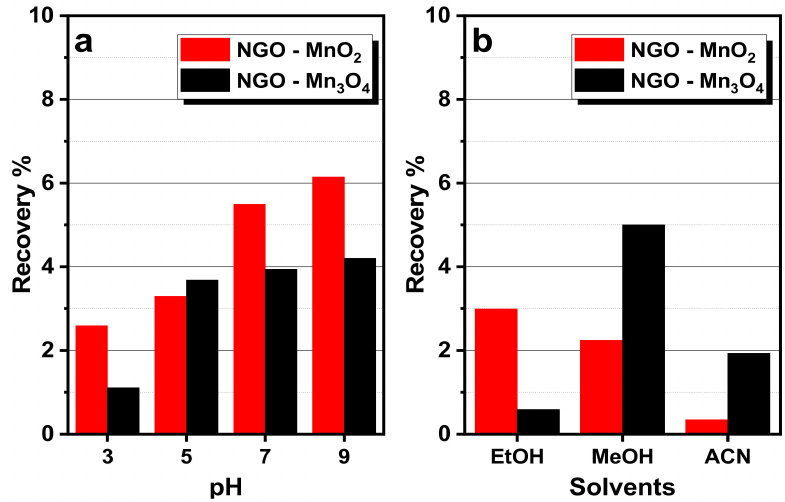
Figure 8. Elution experiments by ( a ) deionized water ( b ) ethanol, methanol and acetonitrile of the loaded the NGO–MnO 2 and NGO–Mn 3 O 4 nanocomposites (Co = 100 mg / L, m = 0.01 g, V = 0.02